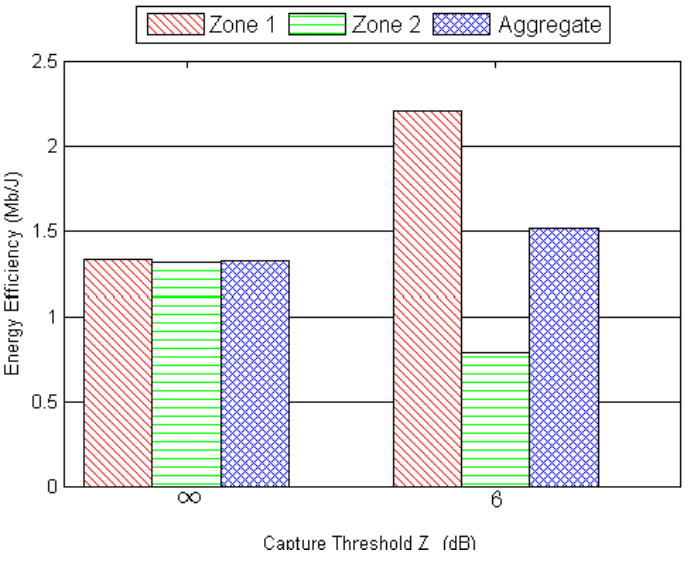
Figure 8. Energy efficiency comparison for different values of capture